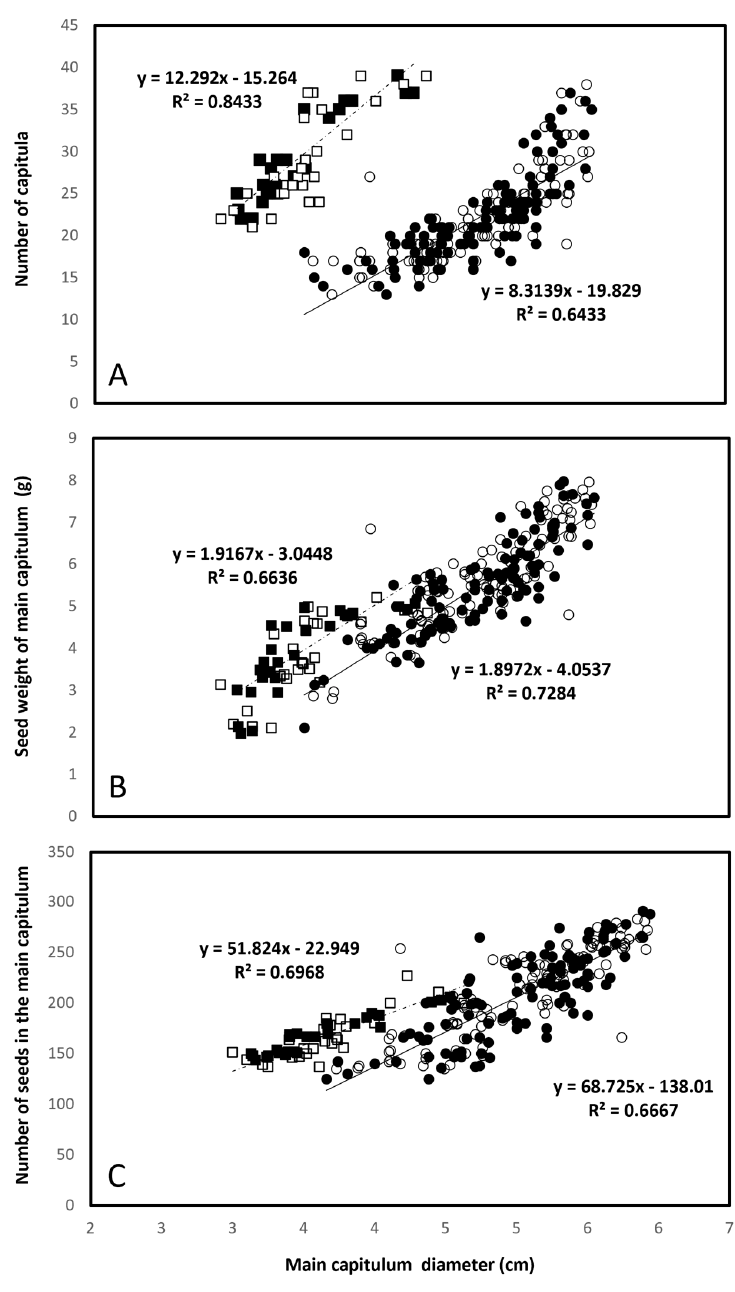
Figure 6. Number of capitula per plant ( A ), seed weight of the main capitulum ( B ), and number of seeds in the main capitulum ( C ) as a function of the main capitulum diameter in five milk thistle ecotypes (‘Ahvaz’, ‘Budakalazi’, ‘Khomin’, ‘Khoram Abad’, and ‘Sari’), cultivated under the application of chitosan or TiO 2 treatments (bulk, nanoparticles) at three concentrations (0, 50, and 100 mg L − 1 ). Data of all ecotypes and treatments were pooled across years (Year 1, open symbols; Year 2, closed symbols). In all panels, the dashed lines represent the ecotype ‘Khoram Abad’ (denoted by squares), which was analyzed separately from the remaining four